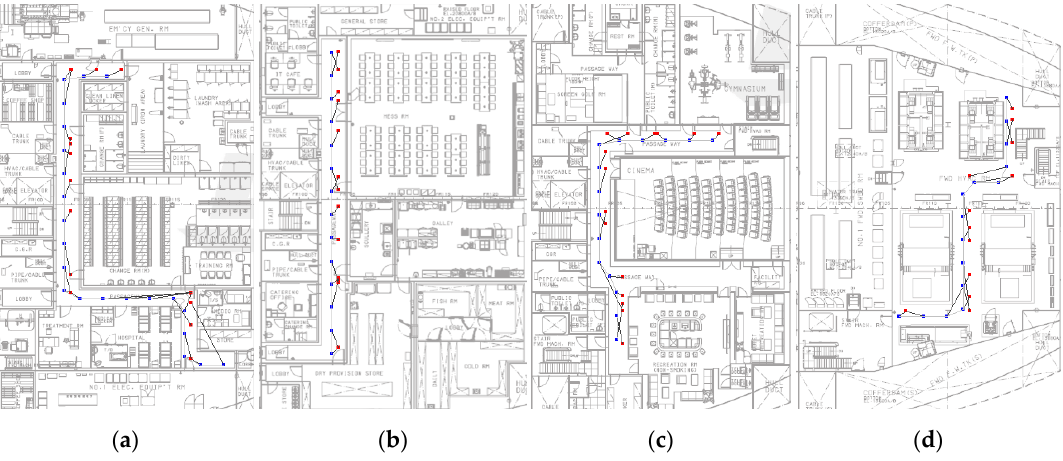
Figure 11. Test data collection path for each deck: ( a ) main deck; ( b ) A deck; ( c ) first deck; ( d ) second deck.